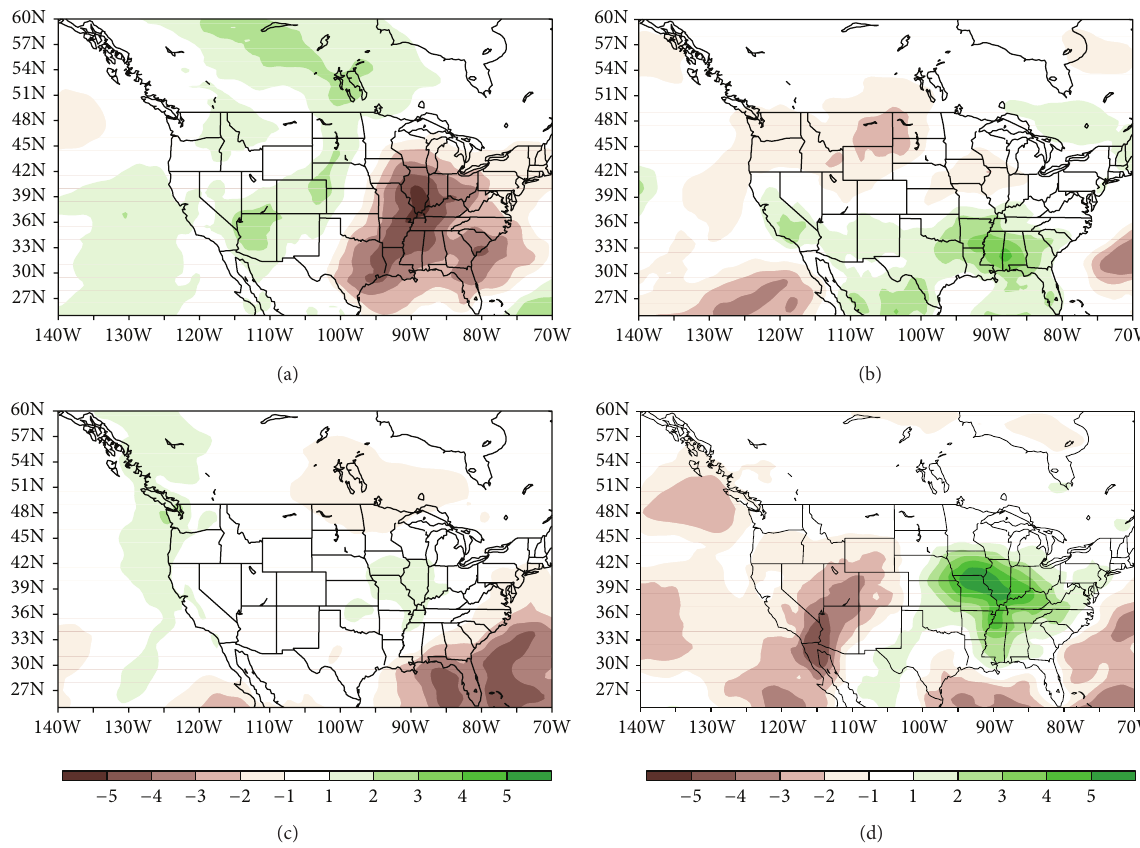
Figure 10: Seasonal precipitable water departures from normal (kg/mm) for (a) AMJ88, (b) JAS88, (c) AMJ93, and (d) JAS93.